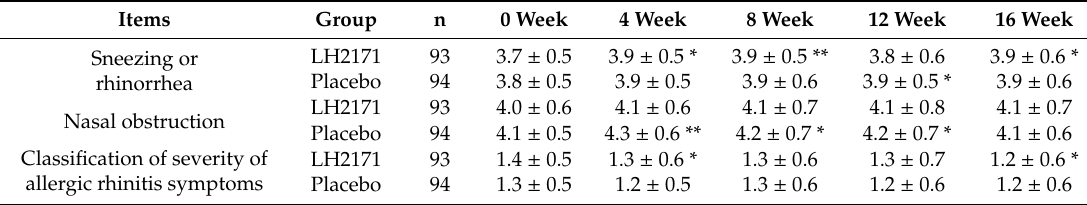
Table 3. Dynamic valuation of the severity of allergic rhinitis symptoms.